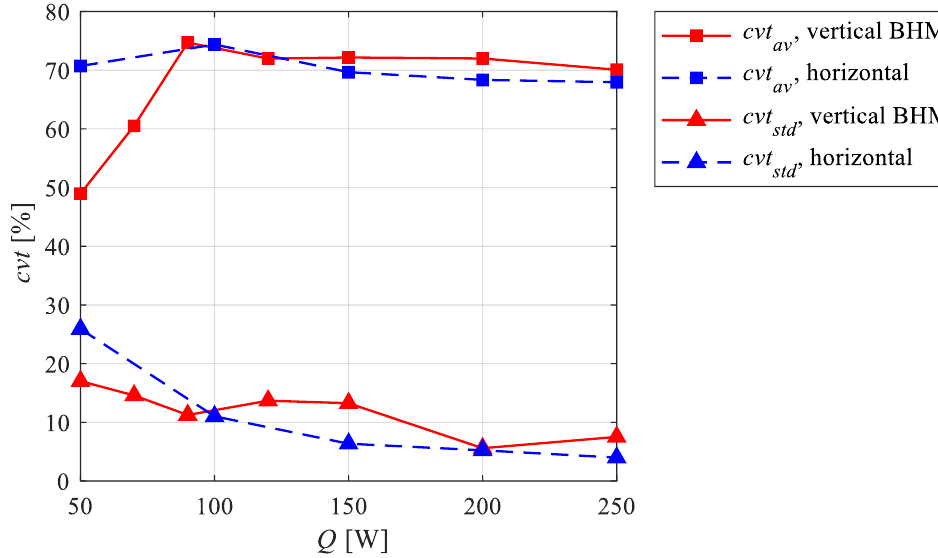
Figure 13. cvt av and cvt std, as functions of the heat load, for the two considered orientations.